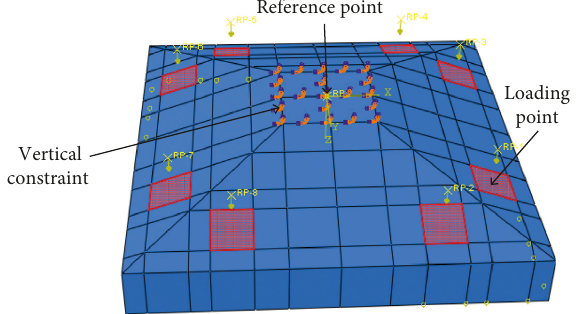
Figure 10: Loading condition and boundary condition for the numerical